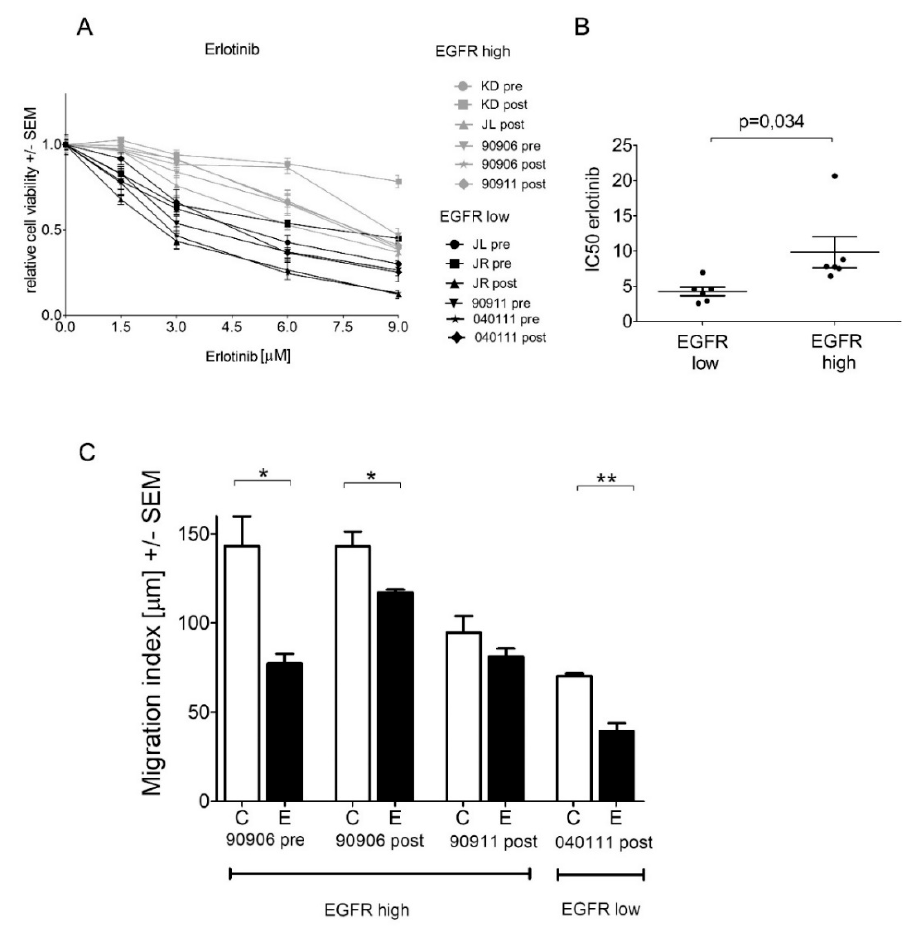
Figure 5. Erlotinib treatment of cell line pairs. ( A ) Growth inhibition effect of erlotinib in five days. ( B ) IC50 erlotinib values in EGFR-low and EGFR-high cells. ( C ) Migration inhibition effect of erlotinib on the four fastest cell lines. Migration index was determined between 48 and 68 h after the erlotinib treatment. C = control, E = erlotinib (6 μ M). Data is shown as the mean +/ − SEM (* p ≤ 0.05, ** p ≤ 0.01, *** p ≤ 0.001).